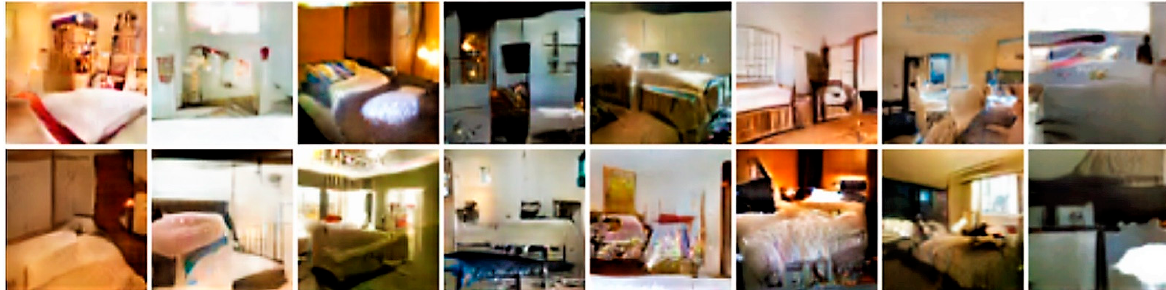
Figure 13. Images generated by Wasserstein GAN with DCGAN generator.